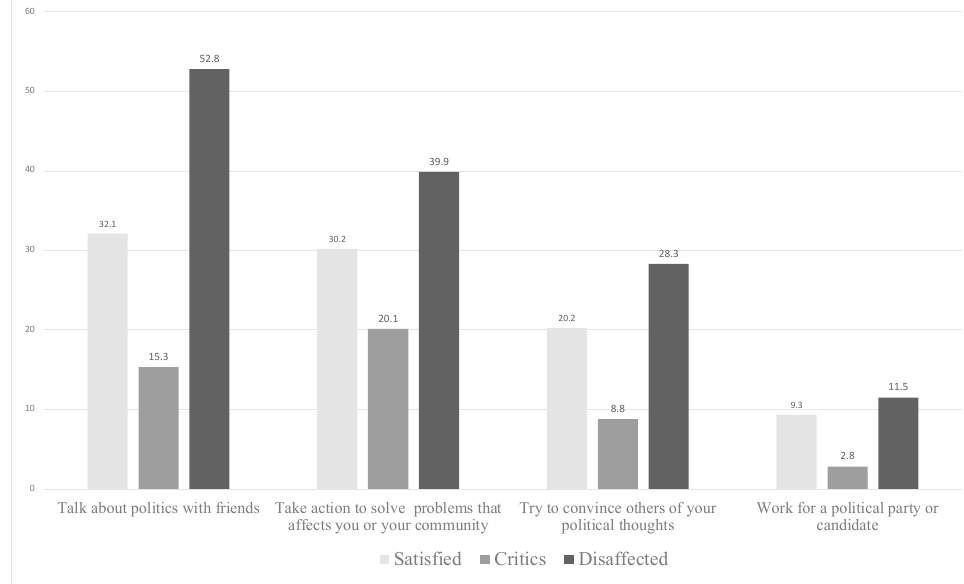
Figure 4. Frequency of political participation: (Very frequently/frequently). Source: Latinobarometer 2020.